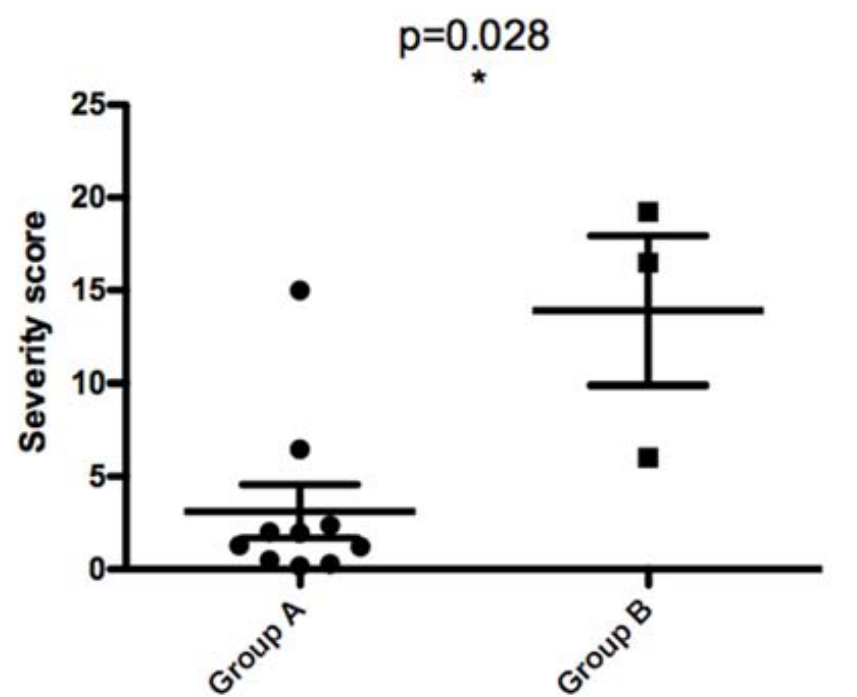
Figure 9. Non-parametric two-tailed Mann–Whitney test measuring the difference in disease severity (severity score as measured in patients) between two L. major isolates groups showing different MLMT genetic profiles. The first group of isolates (Group A) is composed of parasites with the 68 bp-71AT allele, whereas the second group of isolates (Group B) is composed of parasites with the 58 bp-71 AT allele. * indicates statistically significant values.